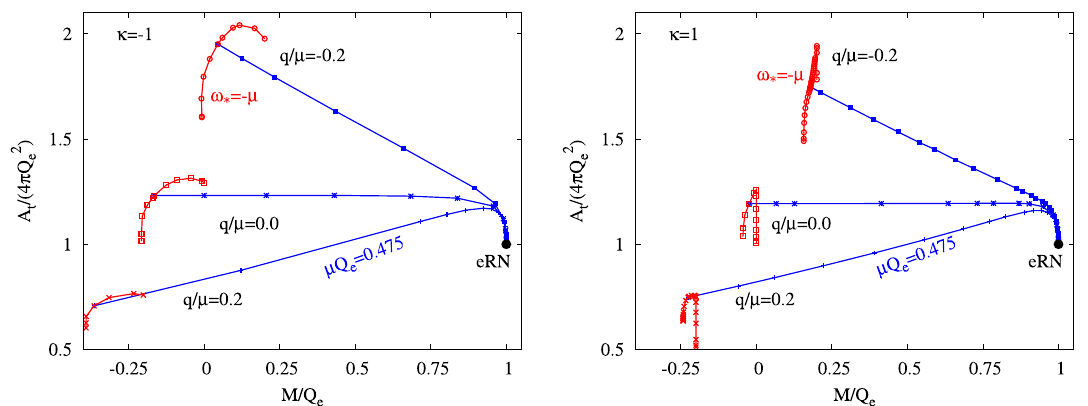
Fig. 5 Throat area scaled to the electric charge, A t /( 4 π Q 2 e ) , as a function of the scaled total mass, M / Q e , for κ = − 1 (left) and κ = 1 (right). Limit configurations with w ∗ = − μ are shown in red, while the blue curves represent solutions with fixed μ Q e = 0 . 475. The black dot indicates the extremal RN